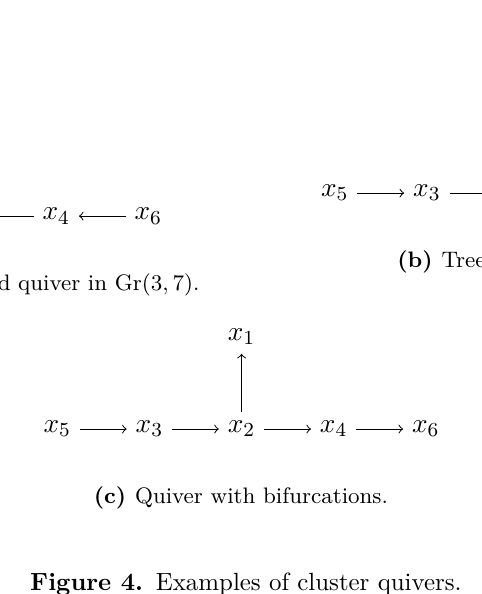
Figure 4. Examples of cluster